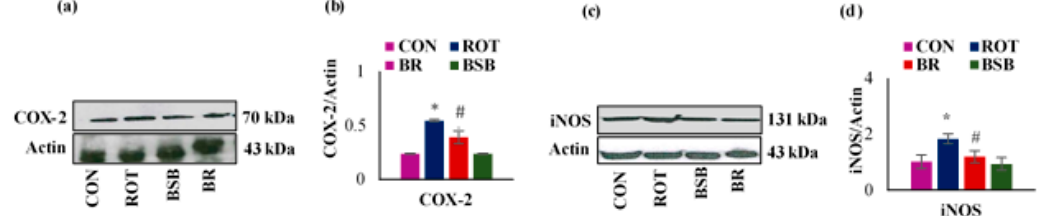
Figure 7. The protein expression and the densitometric analysis of COX-2 and iNOS in the striatal tissues ( a – d ). The quantification of the band intensity showed that a significant increase in the expression level of COX-2 and iNOS in the ROT administered rats when compared as vehicle-injected control rats (CON). However, BSB treatment to ROT injected rats displayed a significant decreased expression of COX-2 and iNOS compared to ROT injected rats. Whereas, rats treated with BSB alone did not shown marked difference in the expression level of COX-2 and iNOS. The values are expressed as the mean ± SEM (n = 3). * p < 0.05 CON vs. ROT; # p < 0.05 ROT vs. BR (One-way ANOVA followed by